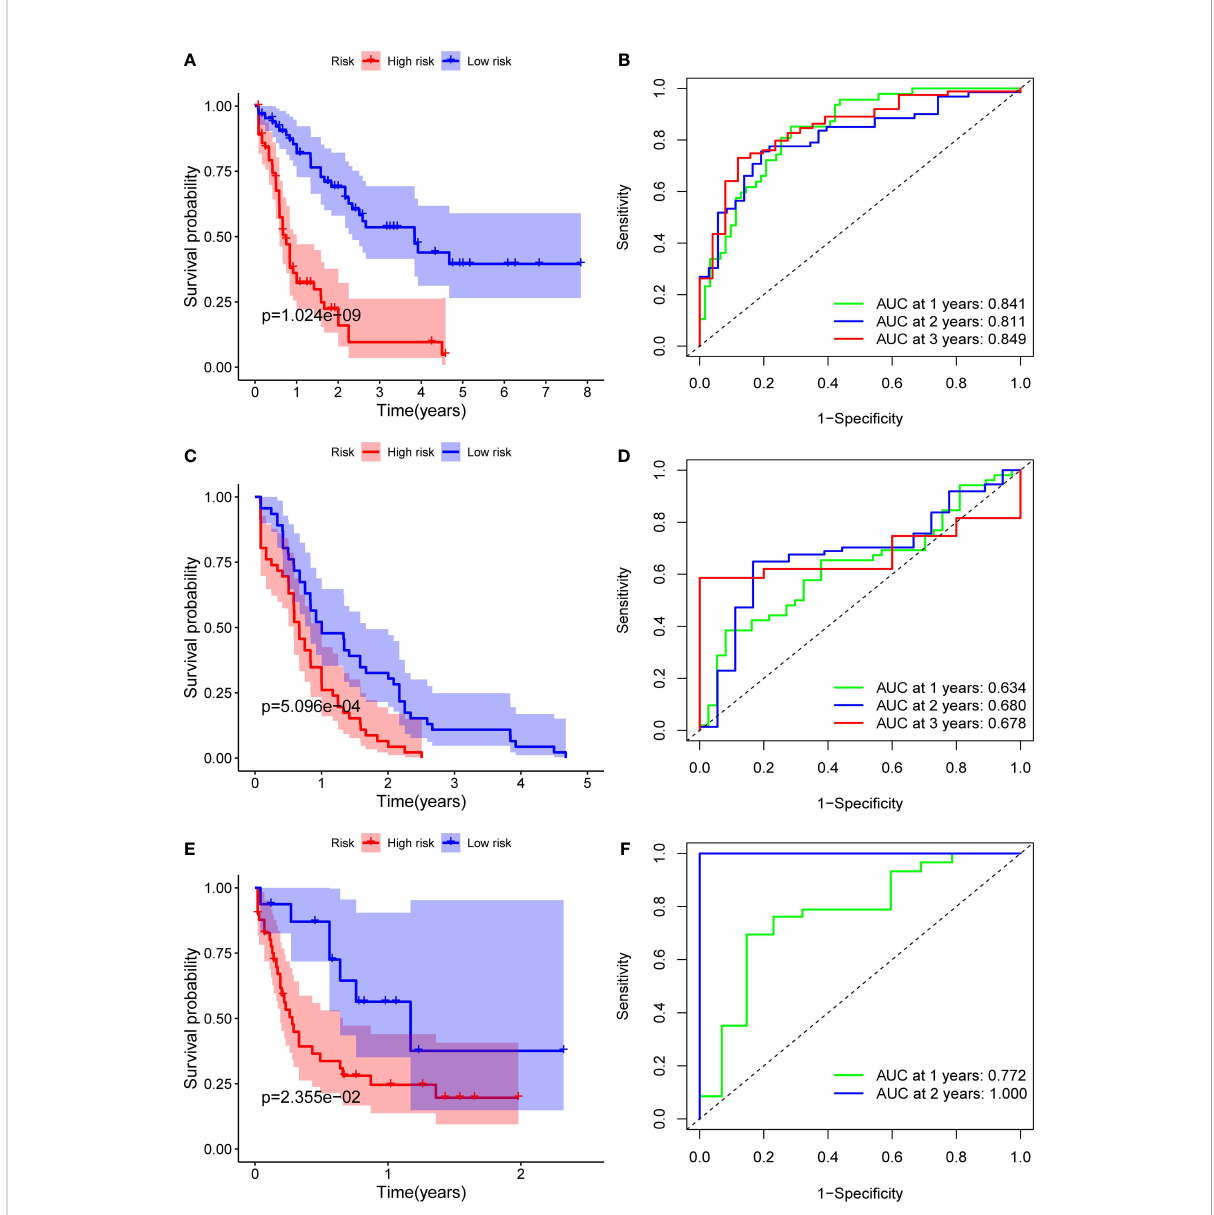
FIGURE 3 Identi fi cation of ten optimal FRGs. (A) Kaplan-Meier curves for the OS of patients in the high-risk and low-risk groups in the TCGA cohort. (B) AUC of time-dependent ROC curves veri fi ed the prognostic performance of the riskscore in the TCGA cohort (C) Kaplan-Meier curves in the ICGC cohort. (D) AUC of time-dependent ROC curves in the ICGC cohort. (E) Kaplan-Meier curves in the FAHWMU cohort. (F) AUC of time- dependent ROC curves in the FAHWMU